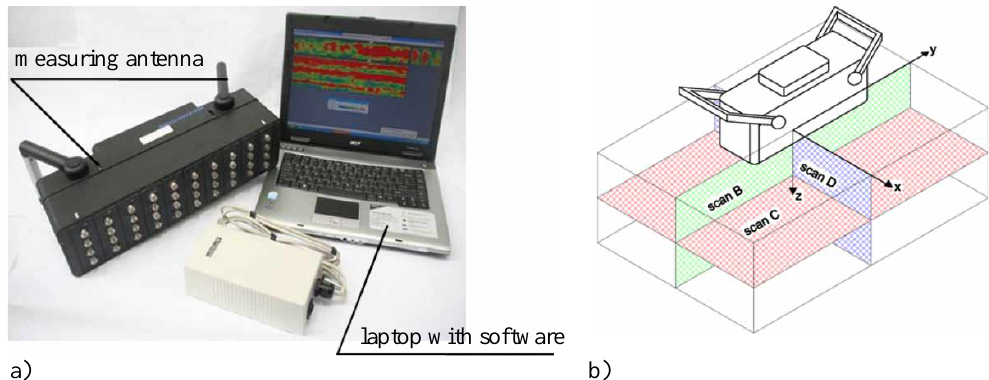
Fig. 1. Ultrasonic tomograph: (a) measuring set; (b) measuring antenna in coordinate system and obtained